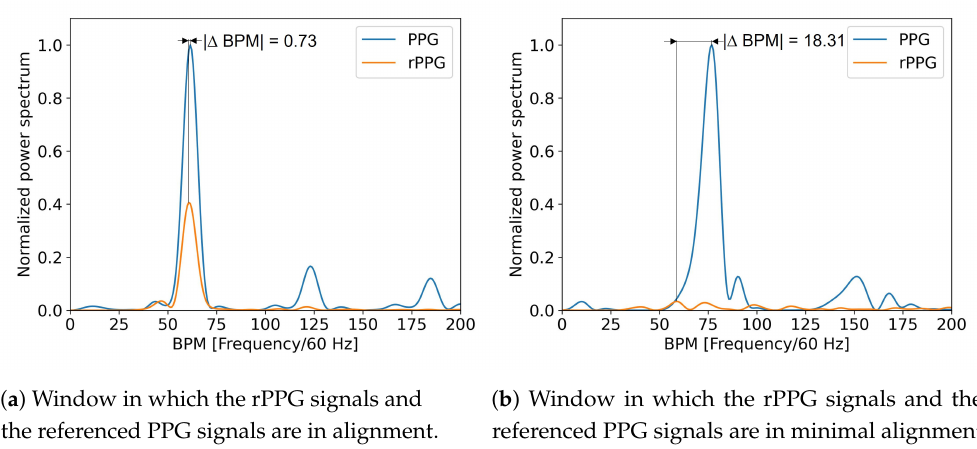
Figure 3. Comparison of a high quality window ( a ) and a low quality window ( b ) in the PS. The high quality signal is from the participant named “Angelo” in the first window. It was recorded with the CHROM rPPG method at the Resting video activity, with the forehead as the ROI: DTW = 1.63, | ∆ BPM | = 0.73, and | r | = 0.72. The signal of low quality is from the participant named “Harun” in the first window. It was recorded with the ICA rPPG method at the Resting video activity, with the left cheek as the ROI: DTW = 2.47, | ∆ BPM | = 18.31, | r | = 0.26. Note: BPM = beats per minute, DTW = dynamic time warping, ICA = independent component analysis, PS = power spectrum, rPPG = remote photoplethysmography, ROI = region of interest, | r | = correlation, OMIT = orthogonal matrix image transformation, and PPG =